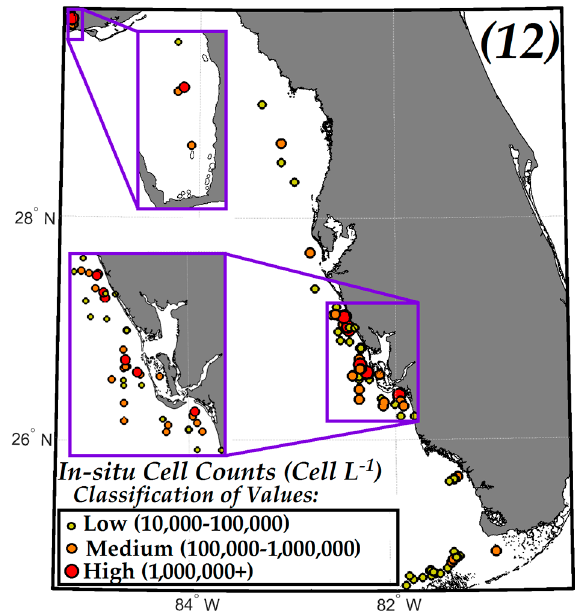
Figure 12. Showing in situ locations of Karenia brevis cell counts cover the range 0.01–9.2·10 6 cells·L − 1 collected by Florida Fish and Wildlife Conservation Commission (FWC). Zoomed areas illustrate the extent of the underline details of KB values available in VIIRS retrievals for the period of 2012–2015.